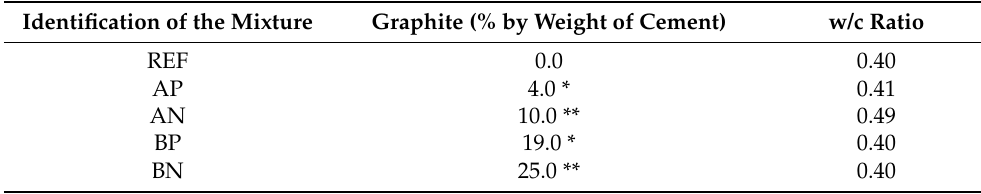
Table 2. Design of the mixtures.